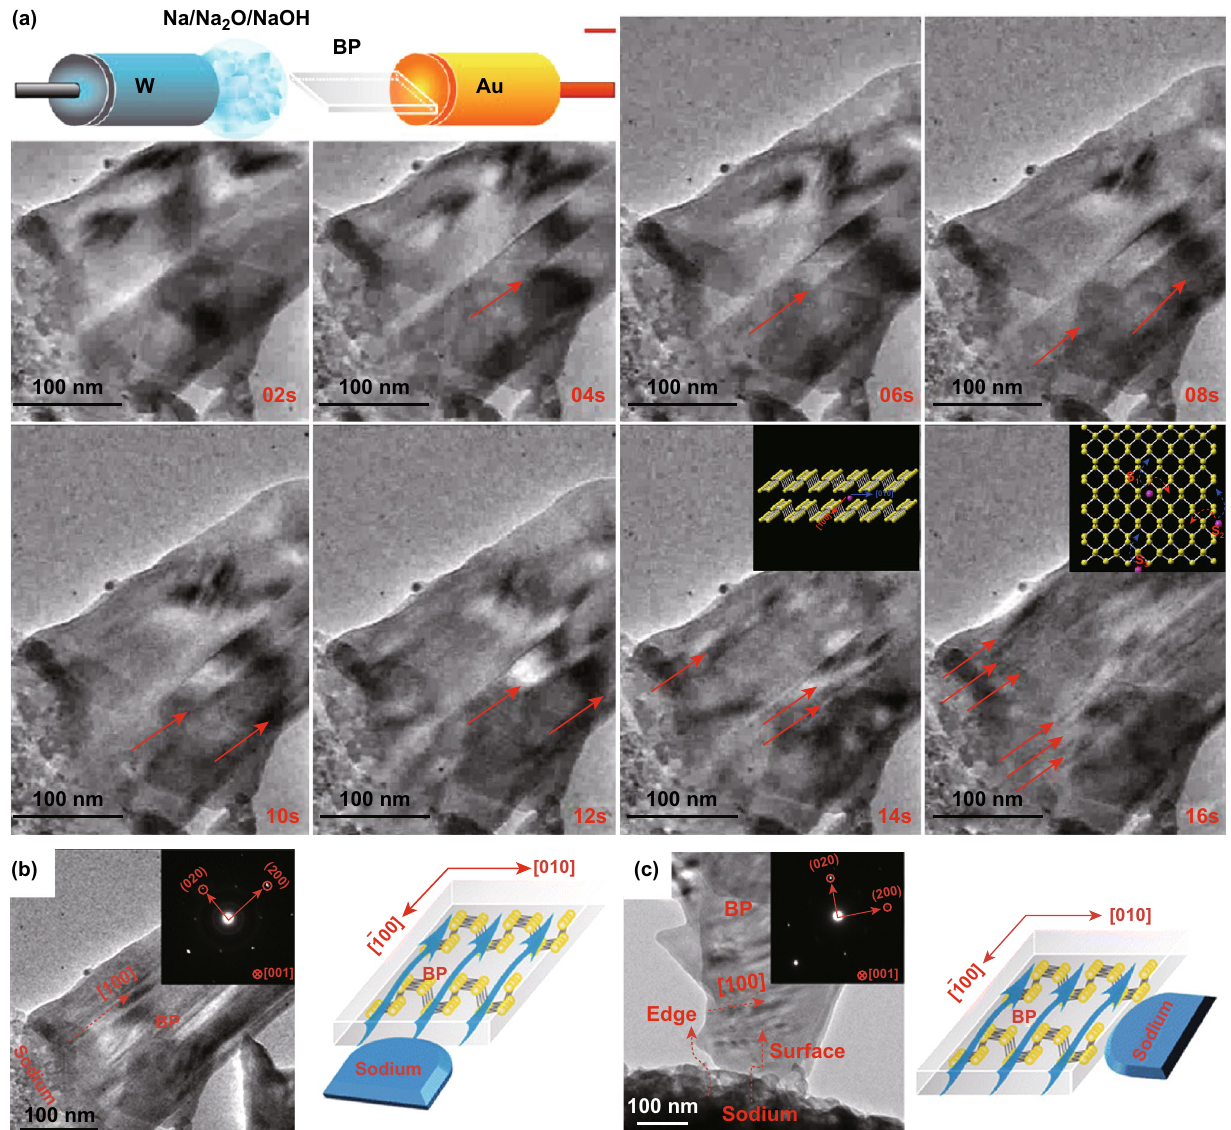
Fig. 11 a In situ TEM snapshots showing the structure evolution of a few-layer phosphorene nanoflake during the sodium transport process. Images are taken during the first 24 s of sodium-ion transport process. The red arrows indicate the position of the formed stripes. The inset is the schematic of the experimental setups. Insets show schematic of sodium-ion transport in interlayer of few-layer phosphorene. Phosphorus and sodium atoms are shown in yellow and purple, respectively. Energy profiles for sodium-ion diffusion in different directions in few-layer phos- phorene. b, c Sodium transport in few-layer phosphorene with different contact geometries with respect to the sodium source. b Contact inter- face normal to the [100] direction. The inset shows corresponding electron diffraction pattern of the few-layer phosphorene in panel a . c Contact interface parallel to the [100] direction. The inset shows the corresponding SAED pattern of the few-layer phosphorene in panel b . Adapted with permission [205]. Copyright 2016 American Chemical